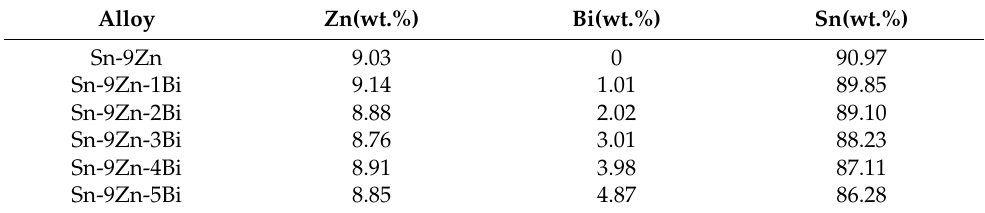
Table 1. Chemical composition of the Sn-Zn-xBi alloys analyzed by inductively coupled plasma (ICP) analysis.